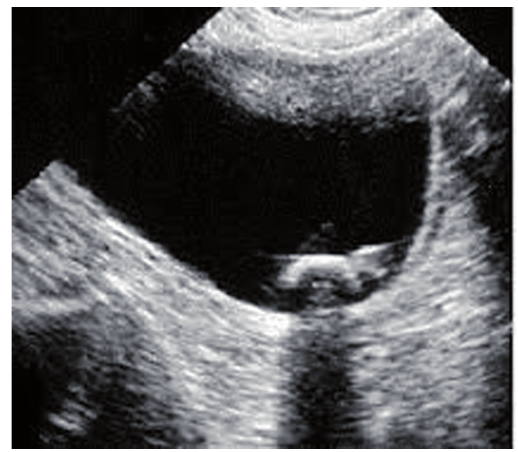
Figure 1a - Ultrasonography image of bladder